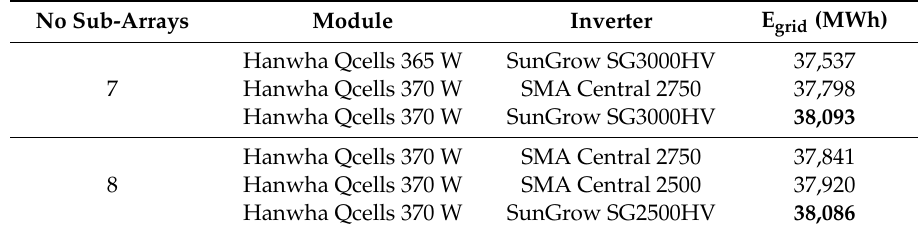
Table 1. Top module / central inverter combinations leading to the higher grid injected energy; seven and eight sub-arrays.